Question: In a single sentence, describe what this figure presents.
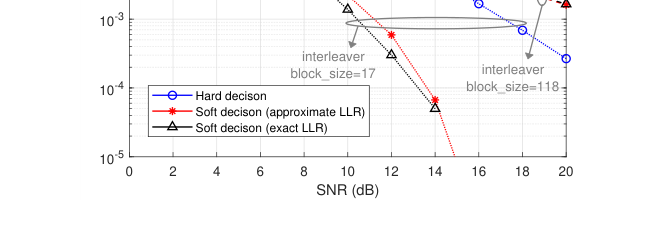
Answer: The impact of the interleaver on the decoding performance in block Rayleigh fading channels.